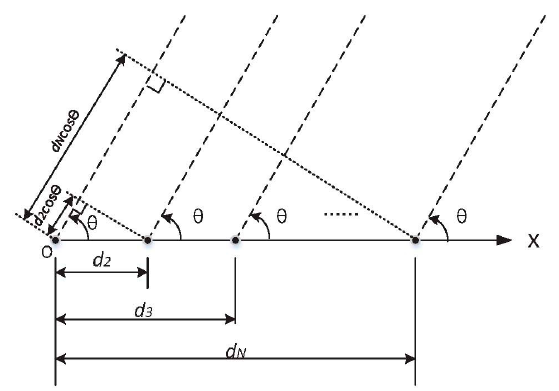
Figure 1. Schematic diagram illustrating the beam synthesis of the N -element linear array antenna.